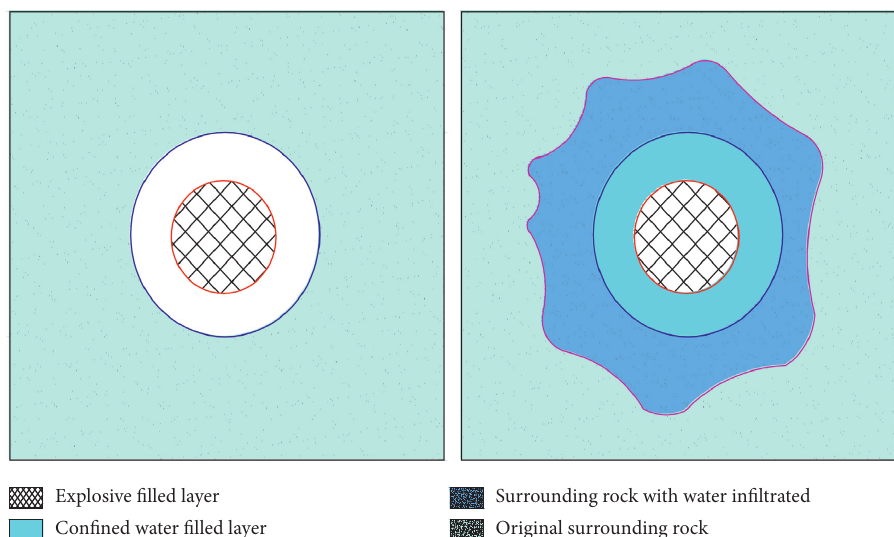
Figure 8: Water-filled confined blasting drilling